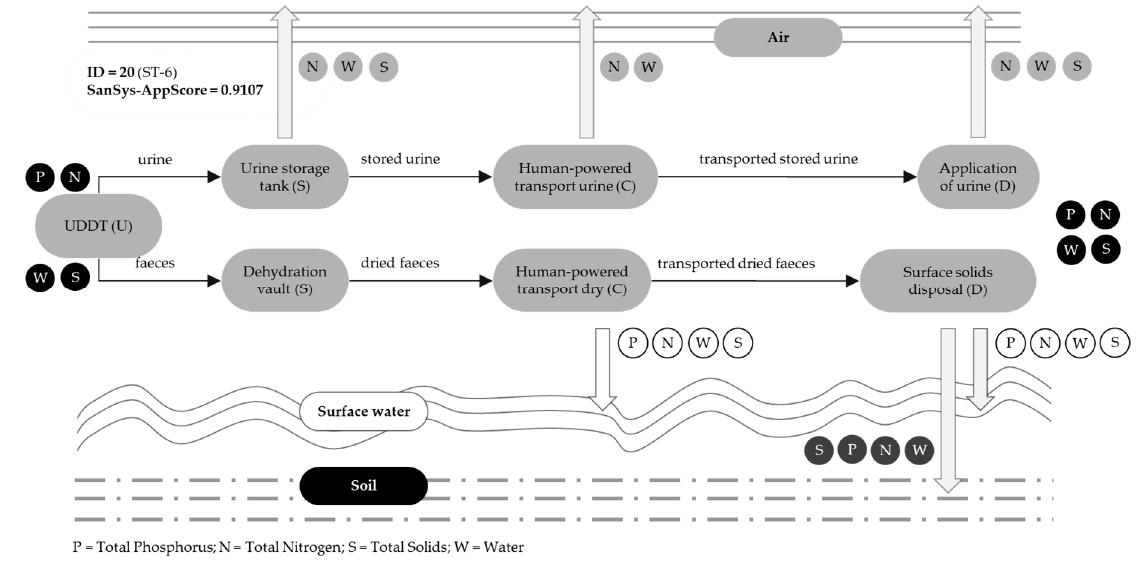
Figure 2. Illustration of one of the selected system options and the possible direction of substances recovery and losses along the sanitation system chain.